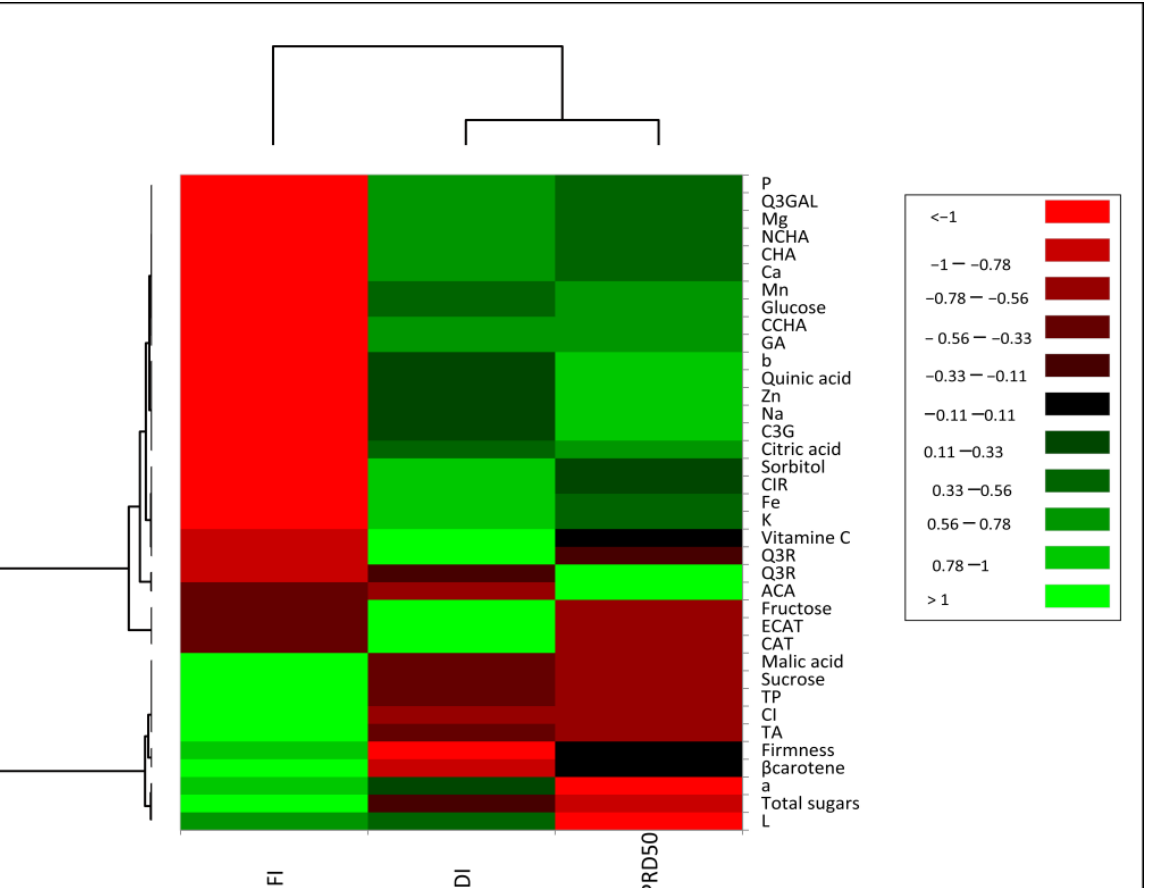
Figure 7. Macronutrient ( A ) and micronutrient ( B ) content in Flordastar peaches grown under FI, DI and PRD50 irrigation treatments, expressed in mg 100 g −1 DM. Data are means ± SD. Different letters refer to significant differences tested by Duncan’s multiple range test ( p < 0.05).